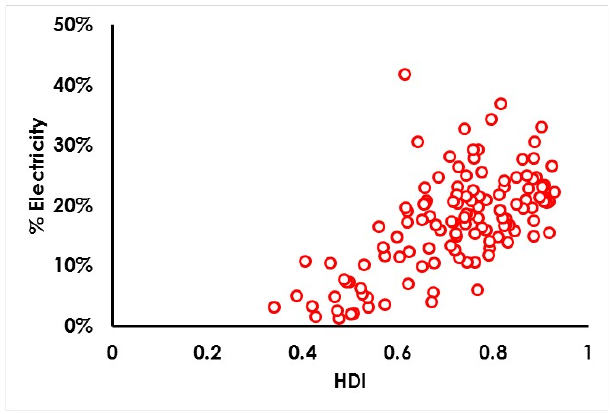
Figure 3. Degree of electrification versus Human Development Index.